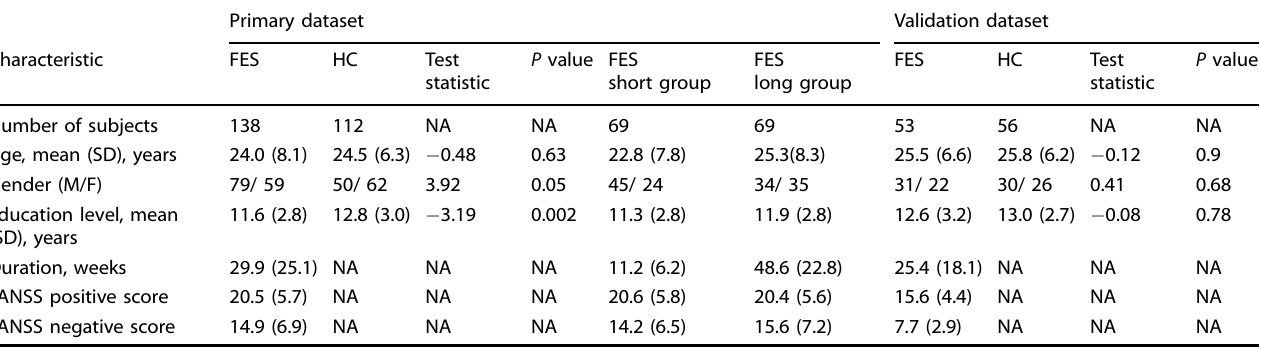
Table 2. Demographic and clinical characteristics of fi rst-episode schizophrenia patients and matched healthy controls in the primary and validation